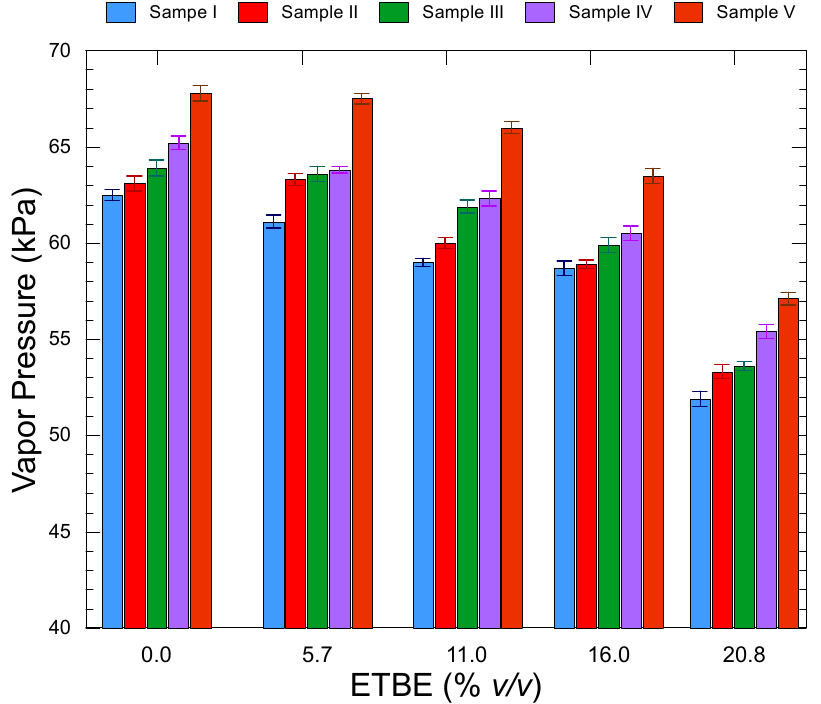
Figure 4. Vapor pressure of blends with bio-ethanol and bio-ETBE in relation to the bio-ETBE content (oxygen content 3.7% m / m in all cases).